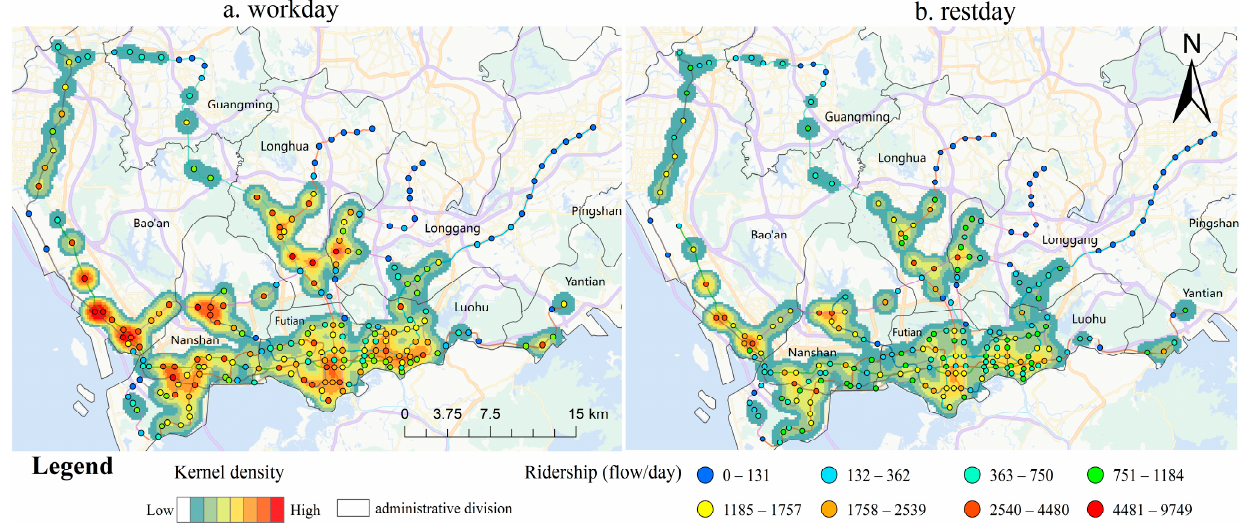
Figure 10. Kernel density distribution and statistics of average daily ridership for DBsMIC by metro station on weekdays and rest days.